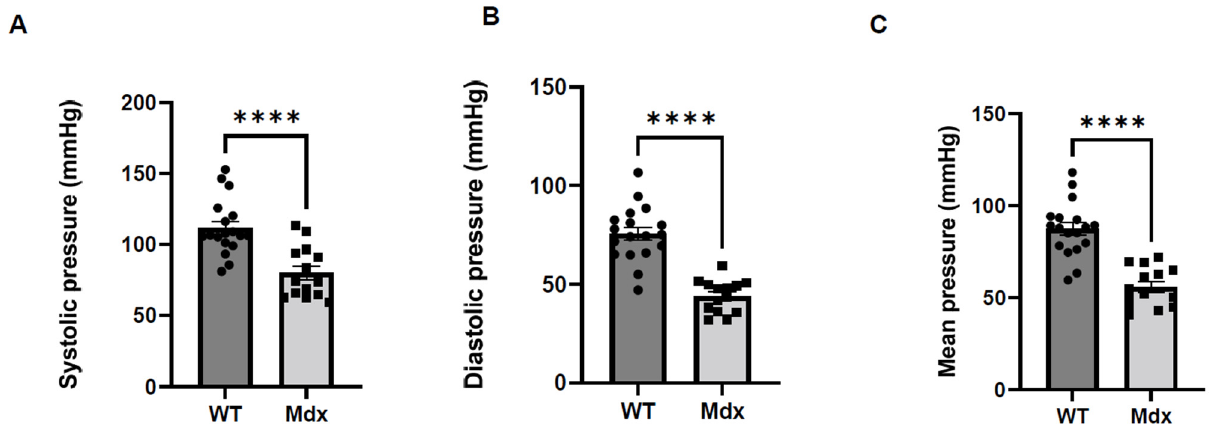
Figure 2. Blood pressure was lower in DMD mut (Mdx) versus wild-type mice. ( A ) Systolic pressure (mmHg), ( B ) diastolic BP (mmHg), and ( C ) mean pressure (mmHg) were collected using a Coda BP system in WT and Mdx mice (**** p < 0.0001, n = 18 for WT mice, n = 14 for DMD mut mice).